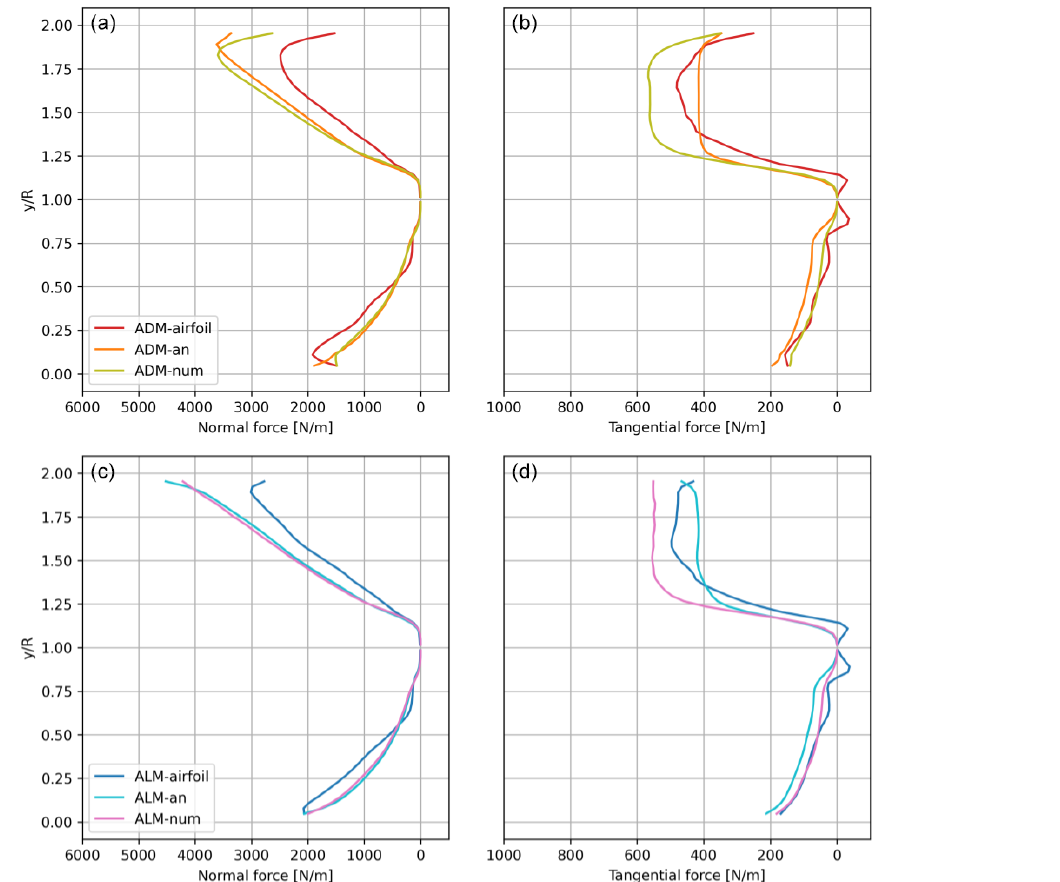
Figure 8. Model comparison for two turbines under uniform velocity inflow conditions of U ∞ = 8ms − 1 : time-averaged (a, c) normal and (b, d) tangential force distributions for WT2 for the azimuthal angles 90 ◦ ± 10 ◦ ( y/R from 0 to 1) and the azimuthal angles 270 ◦ ± 10 ◦ ( y/R from 1 to 2).